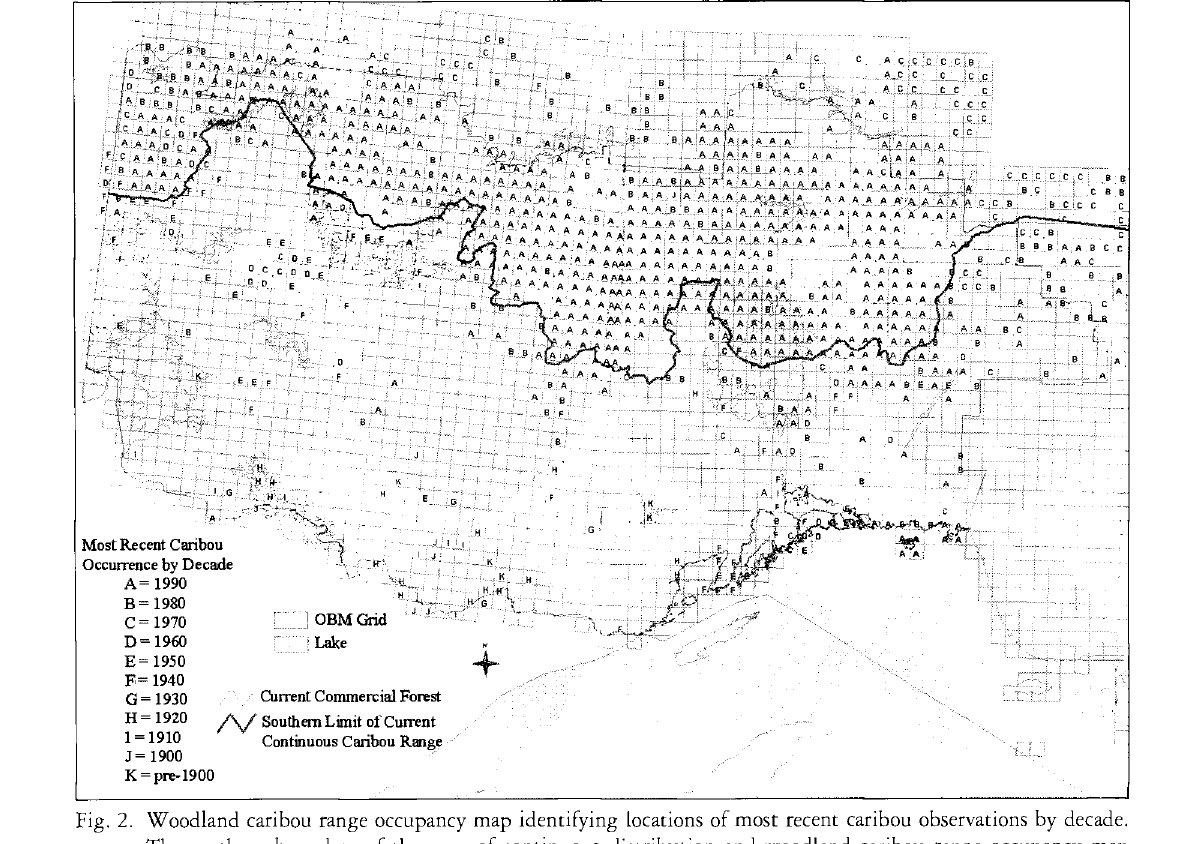
Fig. 2. The southern boundary of the zone of continuous distribution and woodland caribou range occupancy map identifying locations of most recent caribou observations by decade. Observations are recorded on 10 km UTM